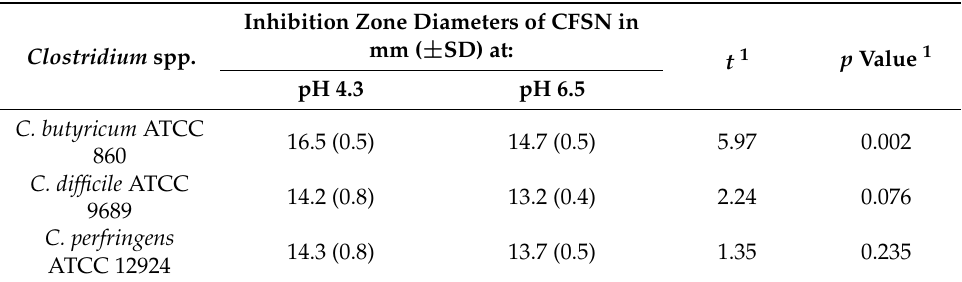
Table 3. Antimicrobial activity of cell-free culture supernatants (CFSN) of L. plantarum ATCC 8014 at pH 4.3 and 6.5 against Clostridium spp. by the agar overlay diffusion.